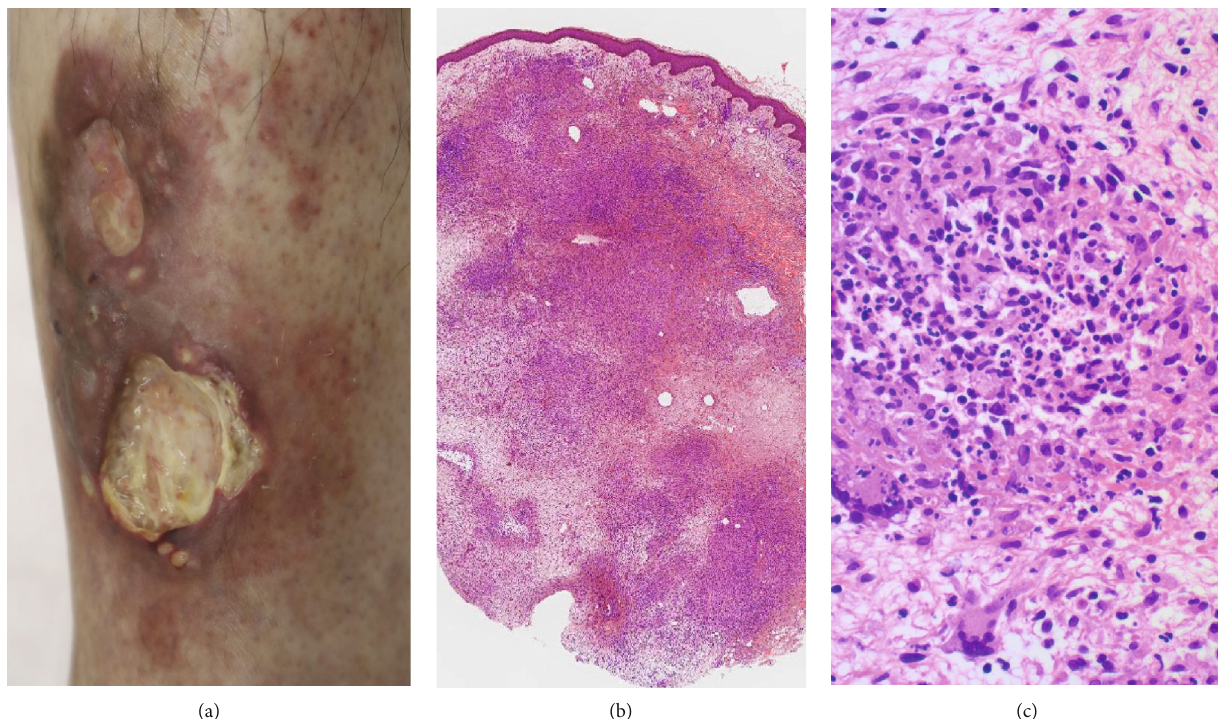
Figure 3: A large nodular and indurated skin lesion with multiple ulcers ((a) gross appearance, (b) H&E, low-powered view, and (c) H&E, high-powered view of the dermis). Multiple ulcers, 2 – 3 cm in size, are formed in the irregular-shaped reddish induration (a). The third biopsy specimen reveals di ff use in fl ammatory in fi ltration in the dermis through subcutaneous tissue (b). Suppurative granuloma (abscess surrounded by epithelioid granuloma) is scattered in the lesion (c). No CMV inclusions are observed any